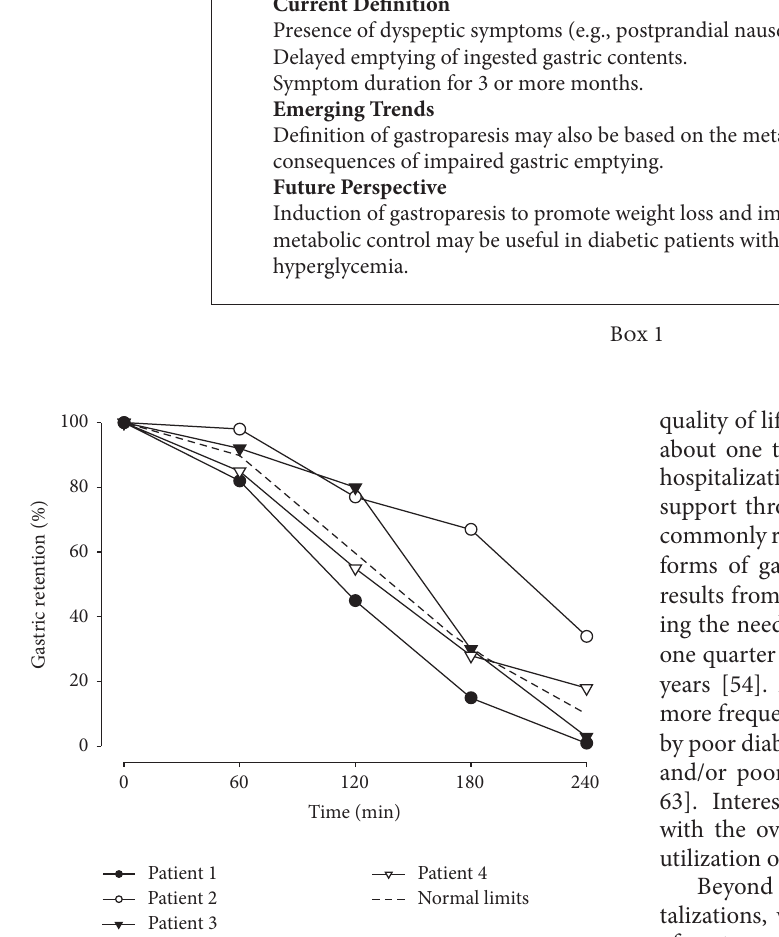
F 1: Sample emptying curves showing the results of scinti- graphic studies of gastric emptying for four different patients as compared to the reference of control persons indicated by the dotted line. While the �ndings for patients 1 and 2 are unequivocal with normal (1) and slow (2) emptying, the other two patients have less consistent results with delay at early (3) or late (4) times points